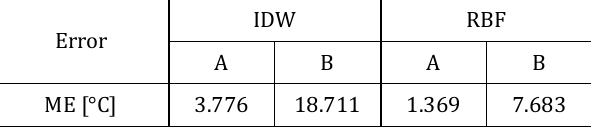
Table 4. Values of the Mean Error, referring to the maps of isotherms of the "Wojkowice" spoil tip generated by means of IDW and RBF (A – the surface the heap, B – inside the